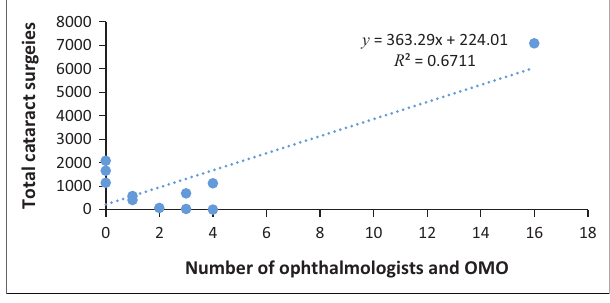
FIGURE 2: Regression analysis of total cataract surgeries versus number of available surgeons.